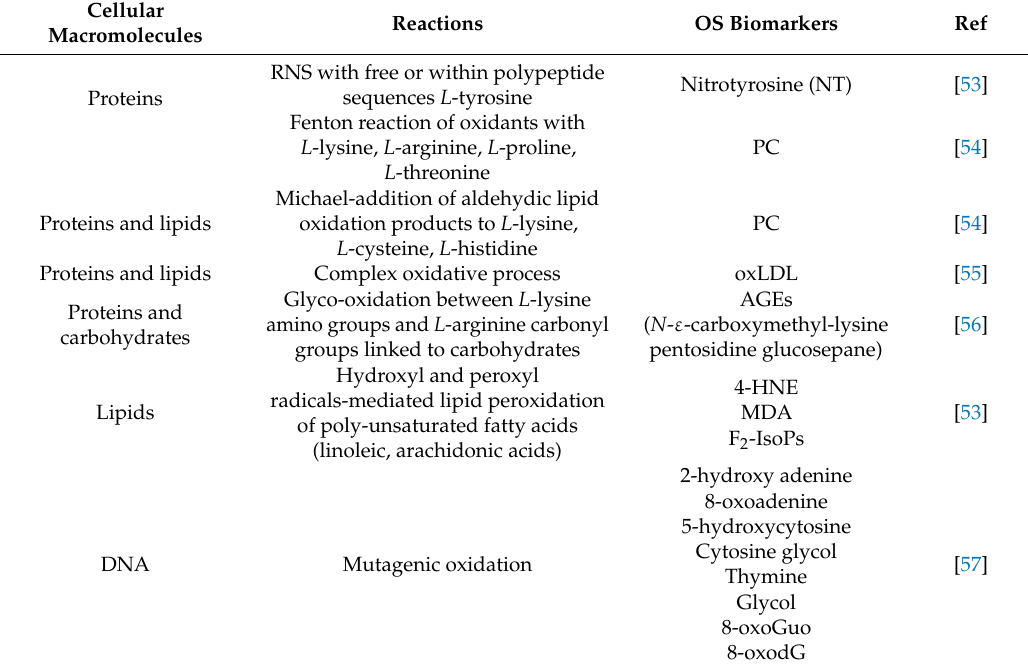
Table 4. Oxidative modification of cellular macromolecules: reactions involved and markers of OS produced in such